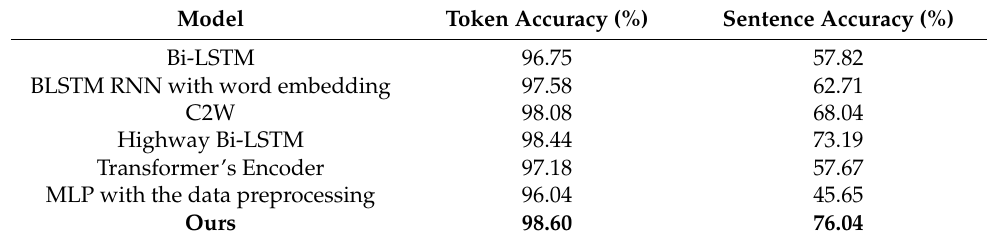
Table 4. Test set accuracy of different